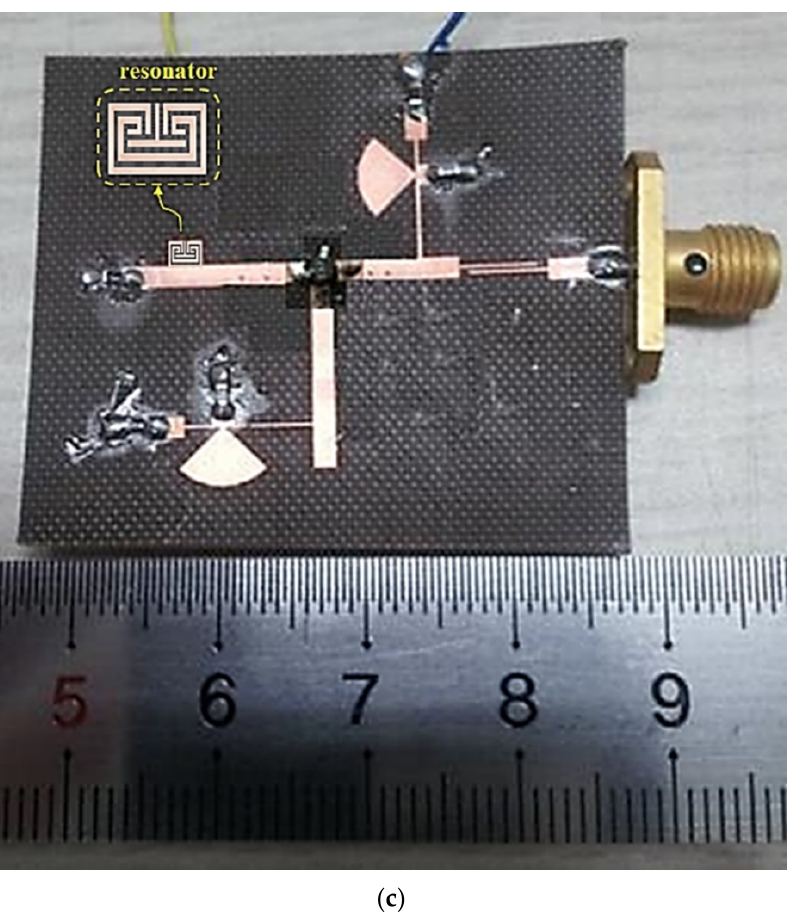
Figure 7. Designed oscillator: ( a ) equivalent circuit, ( b ) structure (layout), ( c ) fabrication. The oscillator is composed of a λ g /4 transmission line (microstrip line) and a radial stub for a DC-bias circuit providing RF power to a wideband open-loaded circuit. The proposed high-Q L resonator is connected to the gate (G) of the GaAs-MESFET. V D , R D , and Rg are the drain (D) bias voltage and drain (D) resistance; further, R S and C S are the source (S) resistance and source capacitance, respectively.